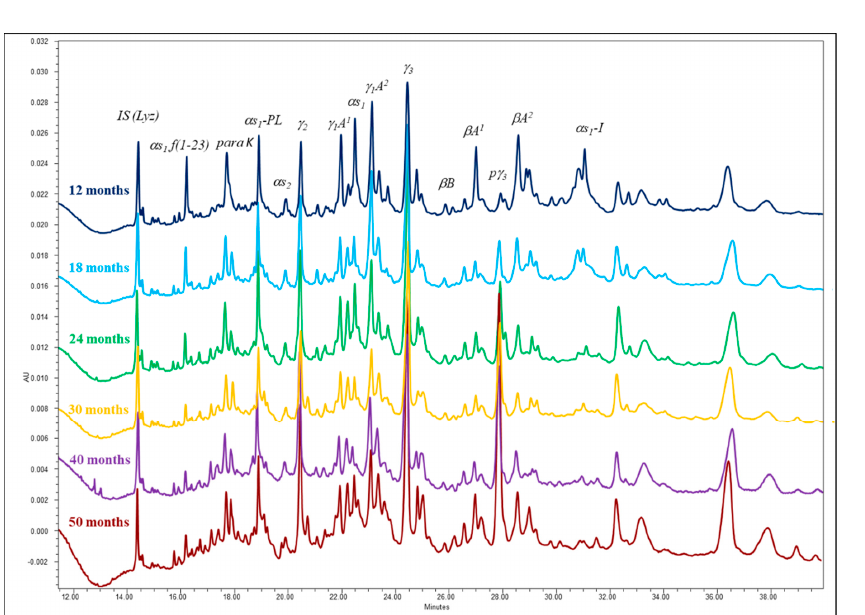
Figure 2. Capillary electrophoresis patterns of Parmigiano Reggiano cheeses ripened up to 50 months. Table 2. Casein fraction ratios ( α s 1 -I/ α s1, α s1 f(1-23)/ α s1 and Σγ / Σβ ), calculated cheese age (months) and total free amino acids (FAA) (g/100 g protein) in Parmigiano Reggiano cheeses ripened from 12 to 50 months.